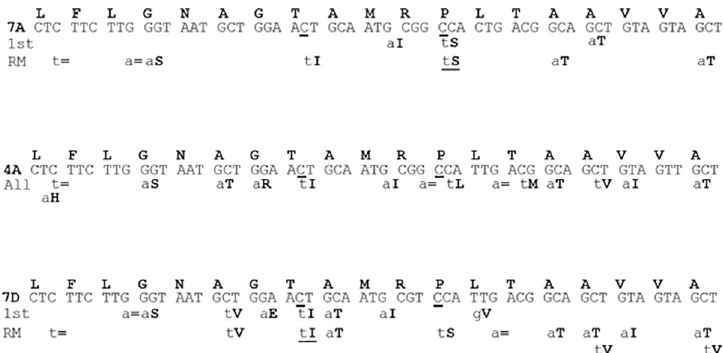
Fig 2. Depiction of TILLING alleles identified in the active site regions of wheat EPSPS homoeologs. Conserved regions around the active site of wheat 7A, 4A and 7D EPSPS homoeologs are depicted with identified novel induced SNPs shown below the homoeolog-specific DNA sequence. The 1 st row refers to the TILLING screen of the initial mutagenized population. The second row labeled “RM” refers to alleles identified upon re-mutagenesis. The nucleotides mutated to create the “TIPS” alleles are underlined. Lower case letters indicate the altered nucleotide while the capitalized bolded letters refer to the amino acid alteration due to the SNP. Since the line that was re-mutagenized contained the 7A P 106 S and the 7D T 102 I alleles, these alleles are repeated in the “RM” row to indicate their presence in the re-mutagenized 2 nd TILLING population. All of the TILLING mutants identified in the 4A EPSPS homoeolog in both TILLING screens are shown on one row. The equal sign indicates a silent SNP that doesn’t alter the amino